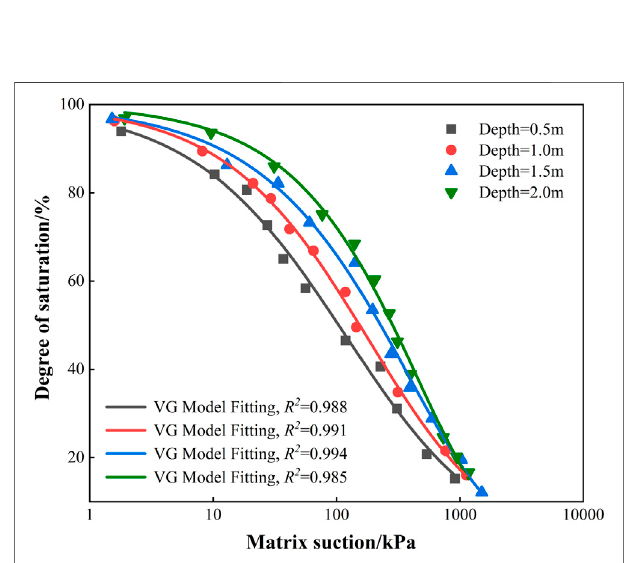
FIGURE 5 | Relationship between matrix suction and degree of saturation.